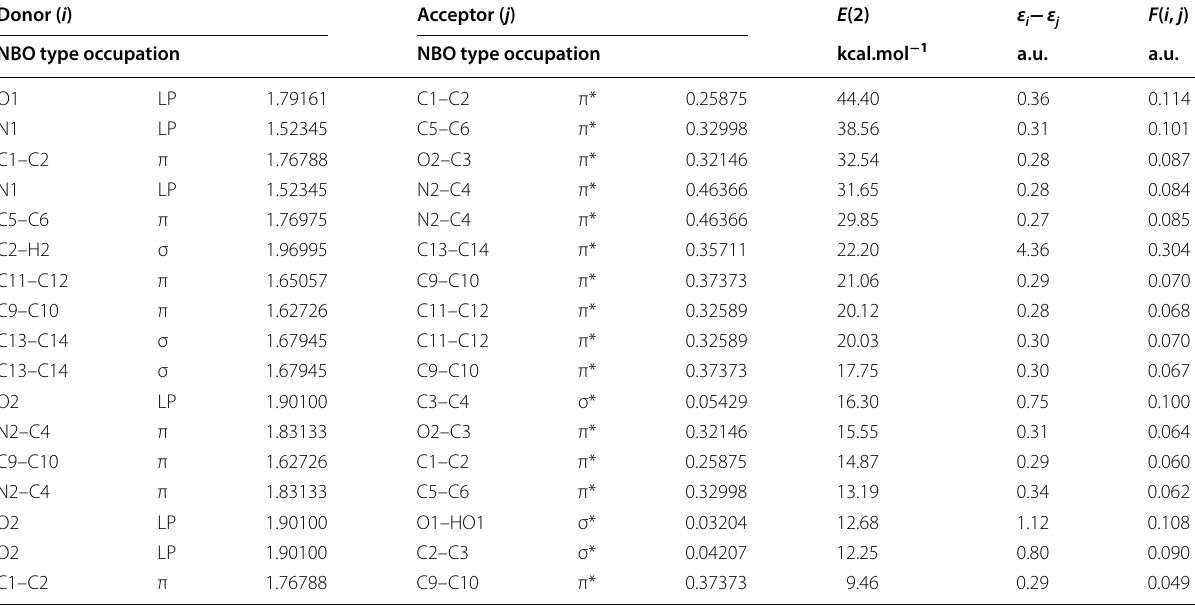
H Br N O 14 13 2